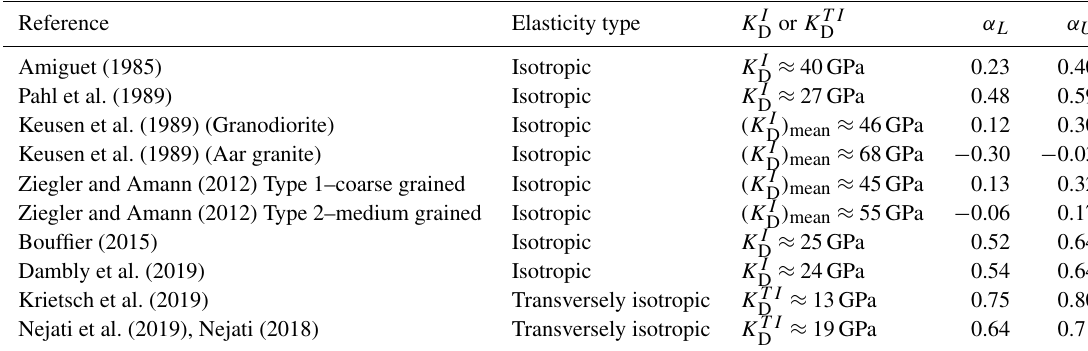
)/K L or K TI , D D S